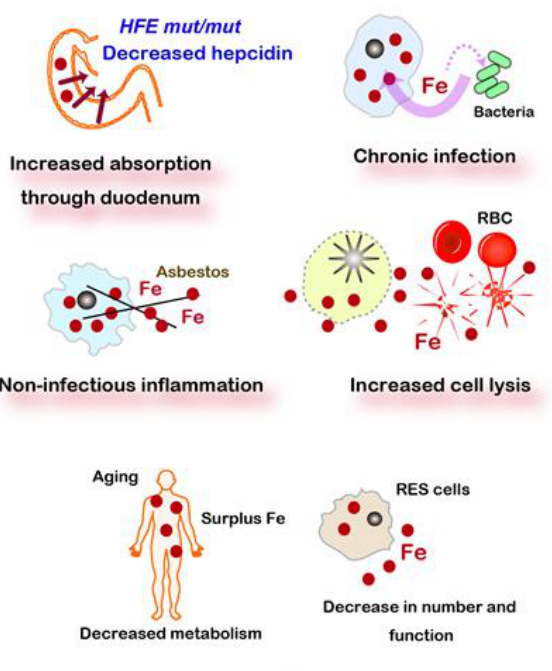
Figure 2. Five different etiologies causing excess iron. Iron metabolism in mammals is a semi-closed system, starting from the absorption at the duodenal epithelia but with no active excreting pathway. Various pathologies, including hemolysis, inflammation, and aging, lead to excess iron. HFE , a responsible gene for genetic hemochromatosis. RBC, red blood cells. RES, reticuloendothelial system, including macrophages, histiocytes, dendritic cells, Kupffer cells, and microglia. Refer to text for details. Table 1. Representative human facts on the association of iron and